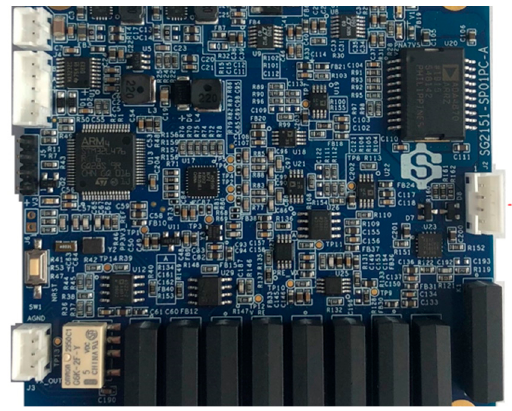
Figure 19. ACSM stress measurement board.